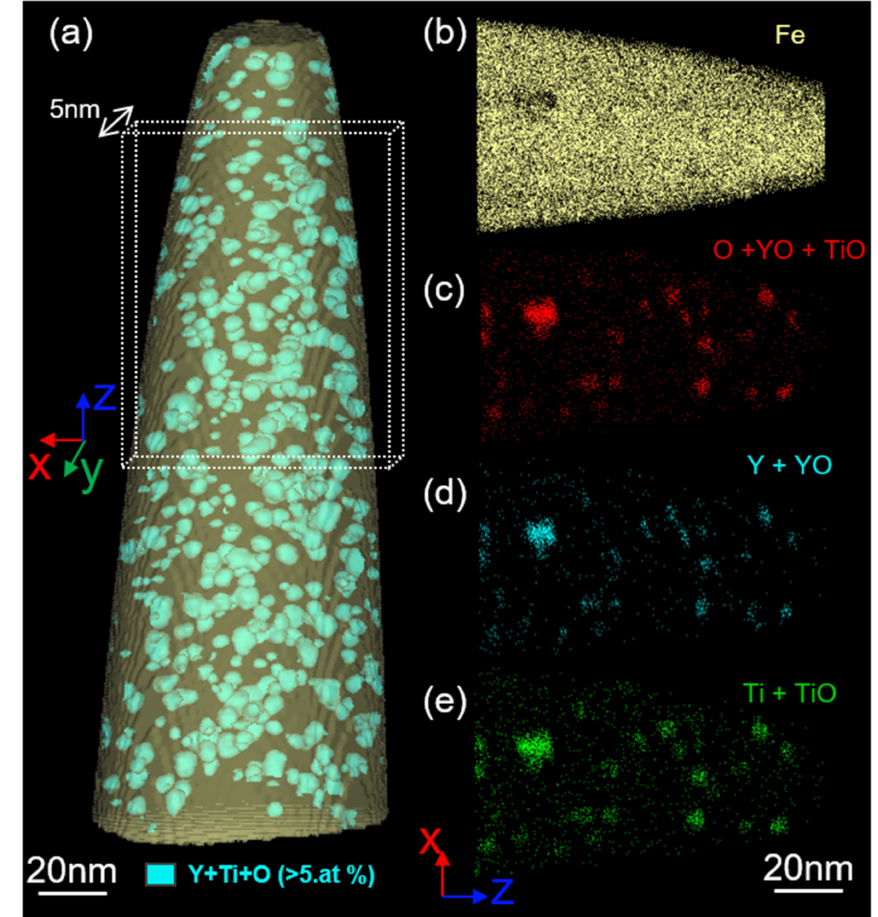
Figure 5. Three-dimensional APT reconstruction of as-received Fe-14Cr ODS: ( a ) an iso-composition surface >5 at.% of O+Y+Ti in blue was used to highlight nano-oxides, ( b – e ) zoomed in insert of region of interest showing map of Fe, O, Y and Ti atoms in as-received Fe-14Cr ODS